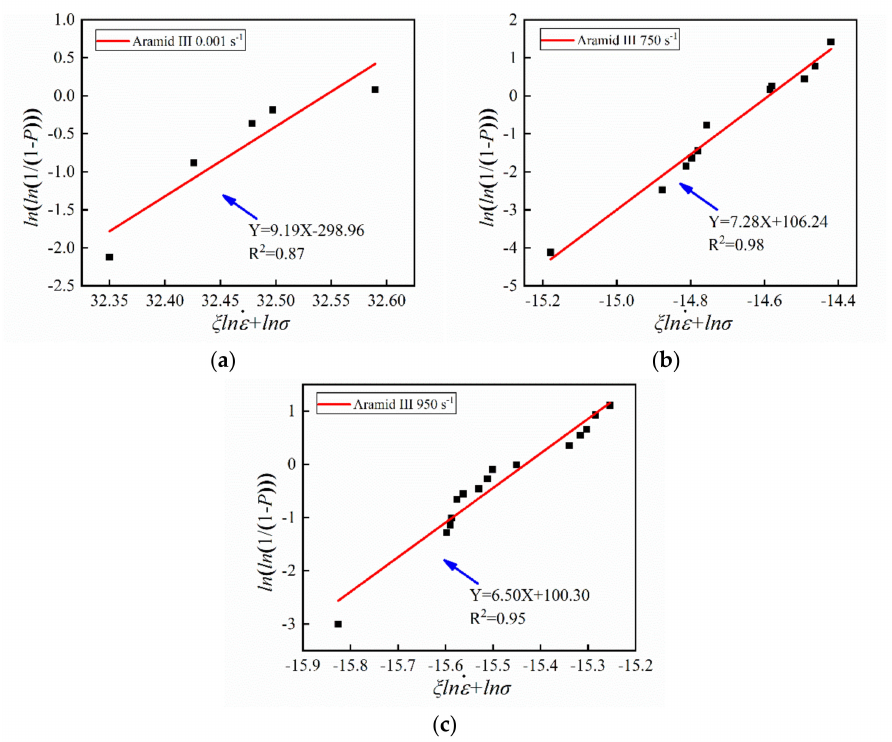
Figure 8. Weibull distribution of single aramid III fibers with strain rate at ( a ) 0.001 s − 1 , ( b ) 750 s − 1 , and ( c ) 950 s − 1